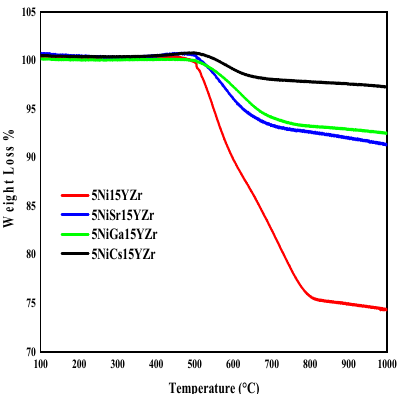
Figure 9. TGA plot for promoted used catalysts at 700 °C after 440 min.